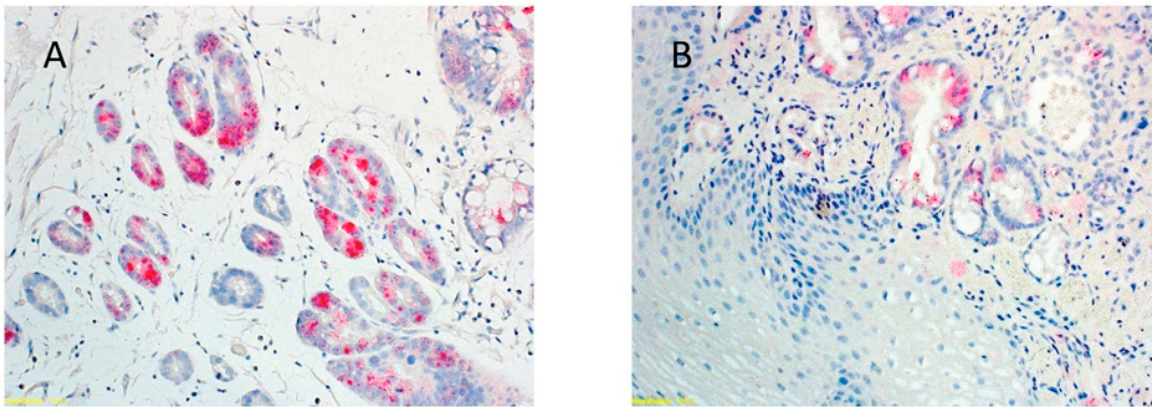
Figure 1. E6/E7 oncogene analysis of hr-HPV 16 and 18 using a novel in-situ hybridization detection technique (RNAScope) in OAC ( A ) and Barrett’s dysplastic ( B ) tissue. Positive staining is diffusely present in the nuclei and cytoplasm as punctate/granular appearance. Oncogene activity is only evident in columnar cells. No staining seen in adjacent squamous tissue ( B ).